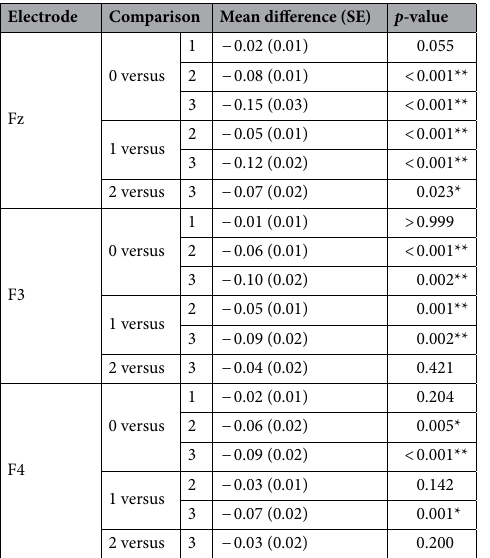
Table 3. Bonferroni-corrected post-hoc pairwise comparisons for theta activity (Power Spectral Density in µV 2 /Hz) at frontal electrodes. Significance levels marked p < 0.05* and p <